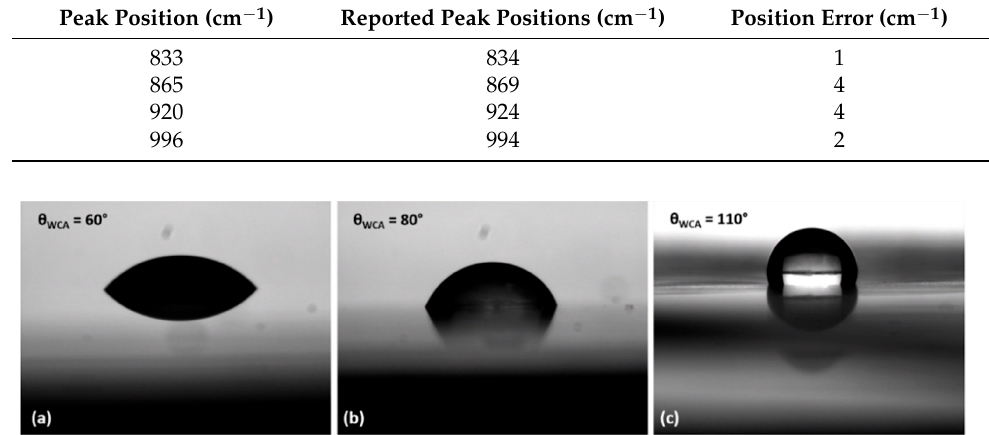
Figure 4. The FTIR spectra of sucrose. Inset shows the zoomed-in peaks in the region (650–1100 cm − 1 ). Table 1. Absorption peak signatures of FTIR spectroscopy of sucrose as indicated by Figure 4. Peak Position (cm − 1 )